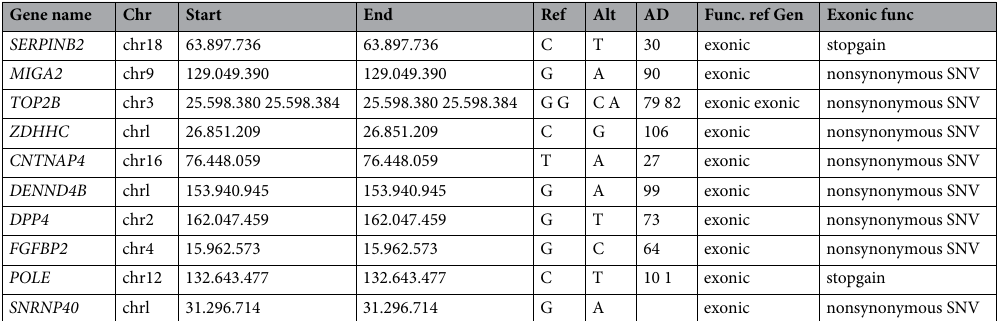
Table 3. List of identified genes. Data of the somatic point mutations in correlation to localization, base exchange, and function. SNV: single nucleotide variant. Chr.: chromosome. Ref.: reference. Alt.: alternative. AD: